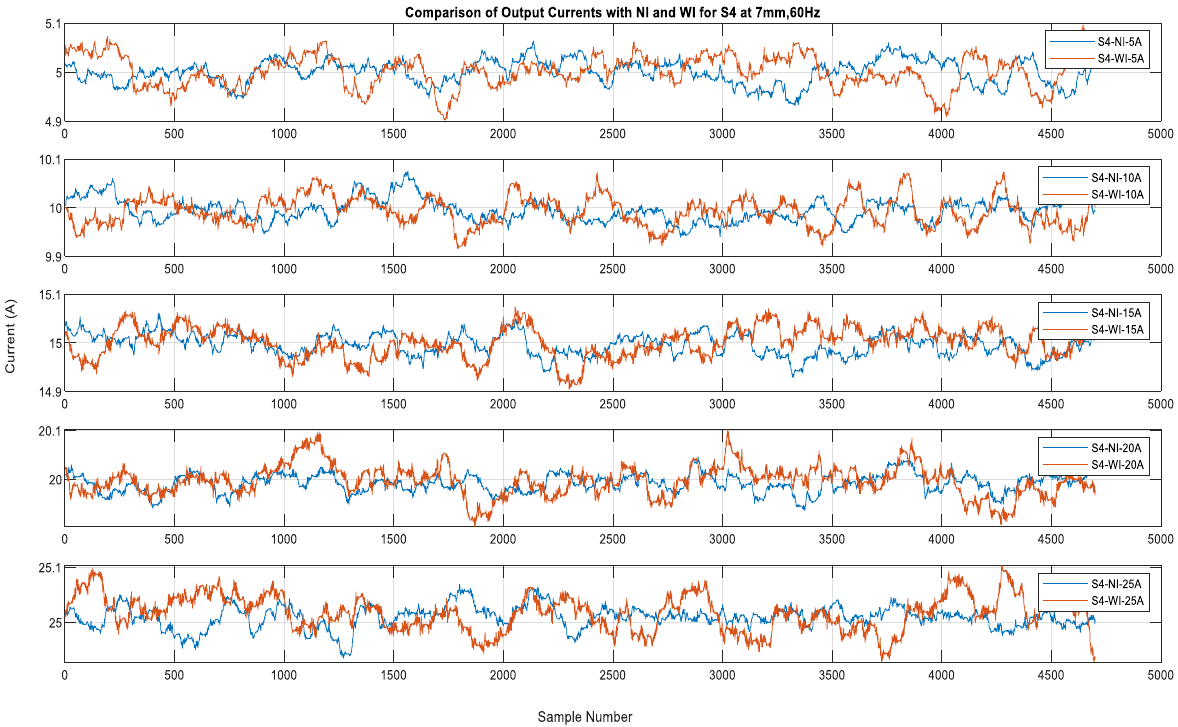
Figure 13. Sensor S4 outputs for currents of 5 A to 25 A: WI and NI cases.